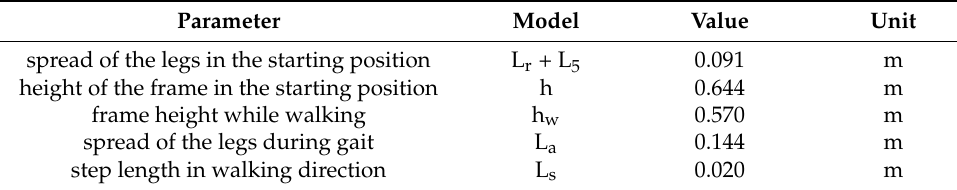
Table 5. Three-dimensional model parameters for the LIPM model.